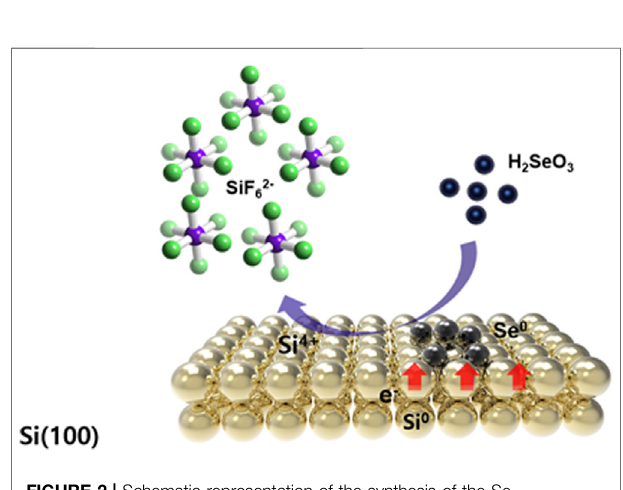
Frontiers in Chemistry |